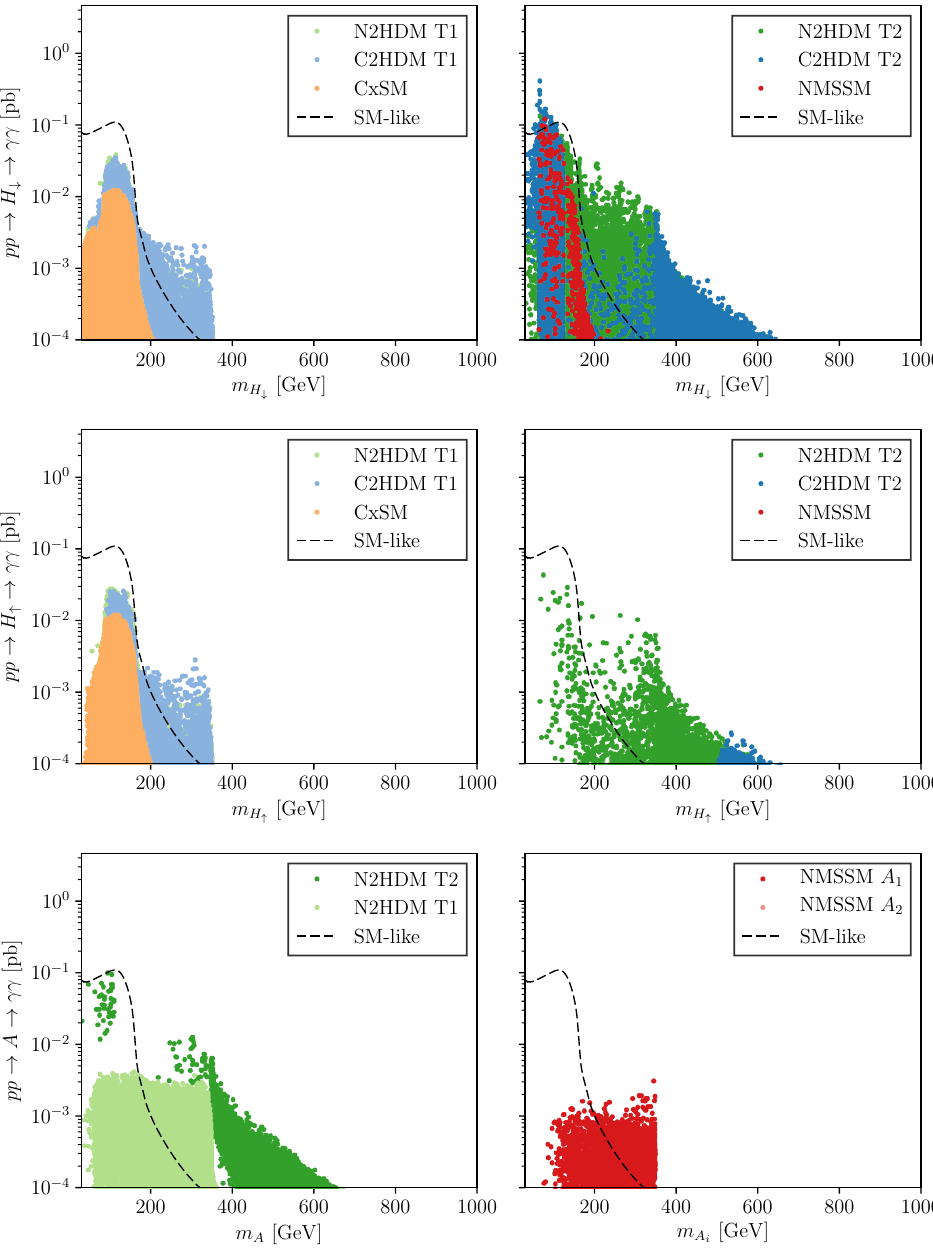
Figure 10 . Same as (cid:12)gure 9 but for the photonic (cid:12)nal state.